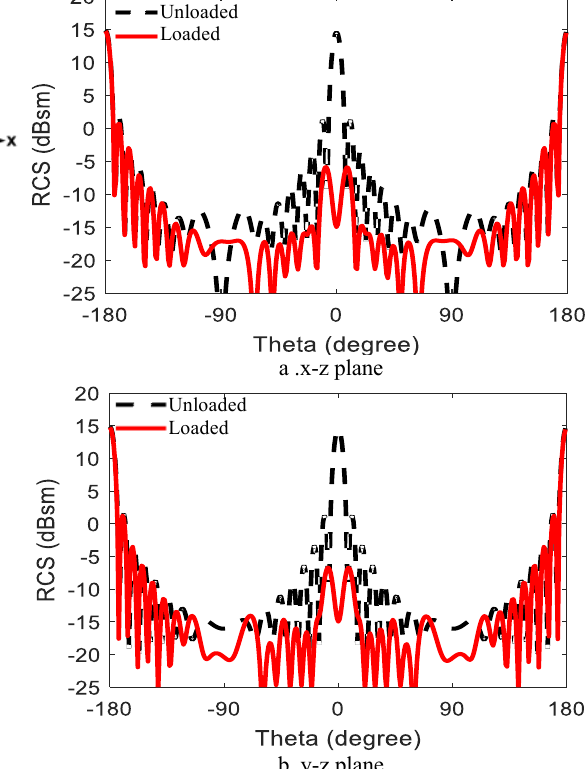
Fig. 14. The RCS variation versus angle for two dimension holes tapering off-diagonal for α=-0.18, R o = 1.5 mm, and ζ =1 at 11.75 GHz in different planes.